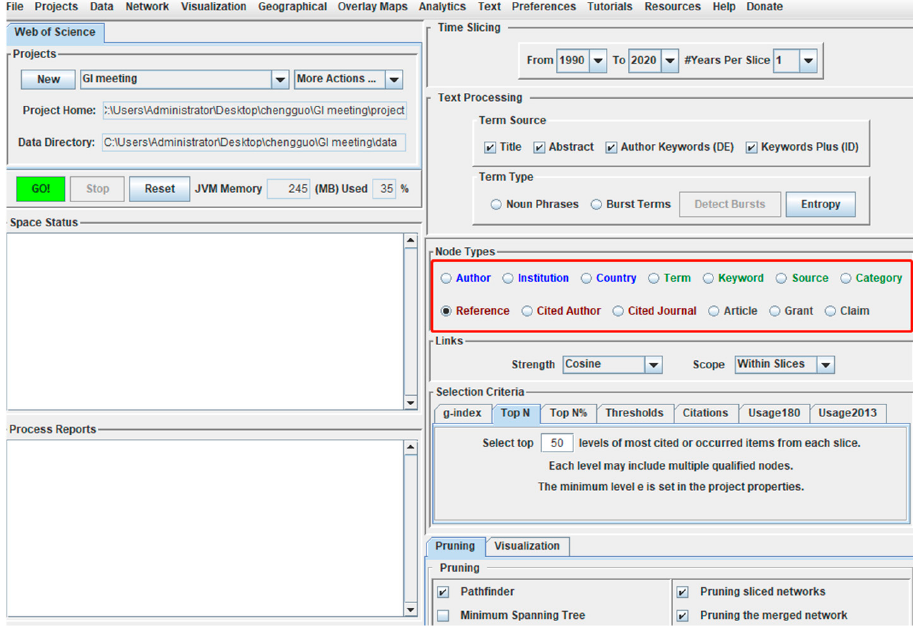
Figure 1. A descriptive, quantitative analysis of the database in Citespace.